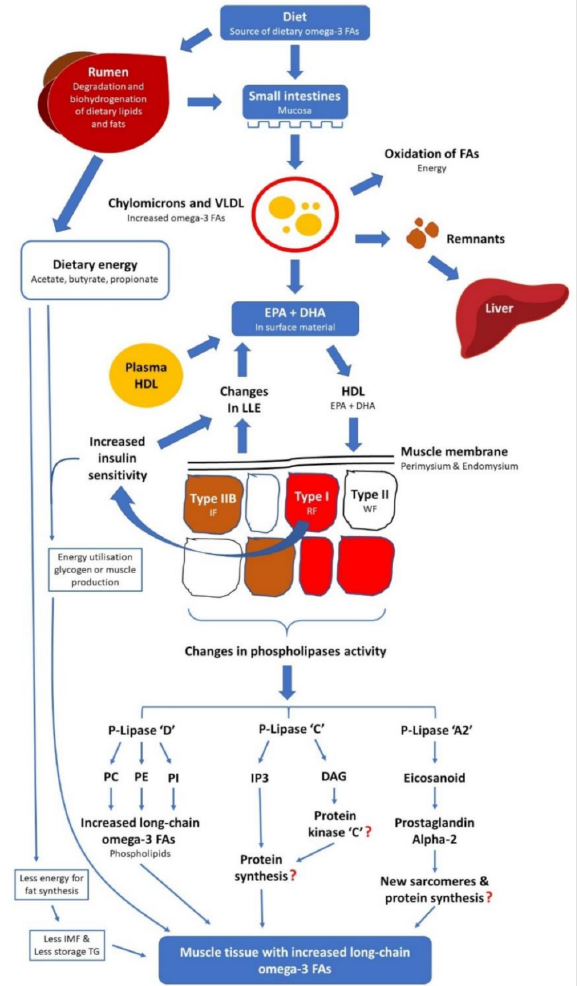
Figure 4. The mechanisms of dietary omega-3 fatty acid digestion and metabolism in ruminants, adapted from Ponnampalam [34]. Abbreviations include fatty acid (FA); very low-density lipopro- teins (VLDL); eicosapentaenoic acid (EPA); docosahexaenoic acid (DHA); high-density lipoproteins (HDL); lipoprotein lipase enzyme (LLE); intermediate fibres (IF); red fibres (RF); white fibres (WF); phosphatidylcholine (PC); phosphatidylethanolamine (PE); phosphatidylinositol (PI); Inositol triphos- phate (IP3); diacylglyceride (DAG); and triglyceride (TG or triacylglycerol